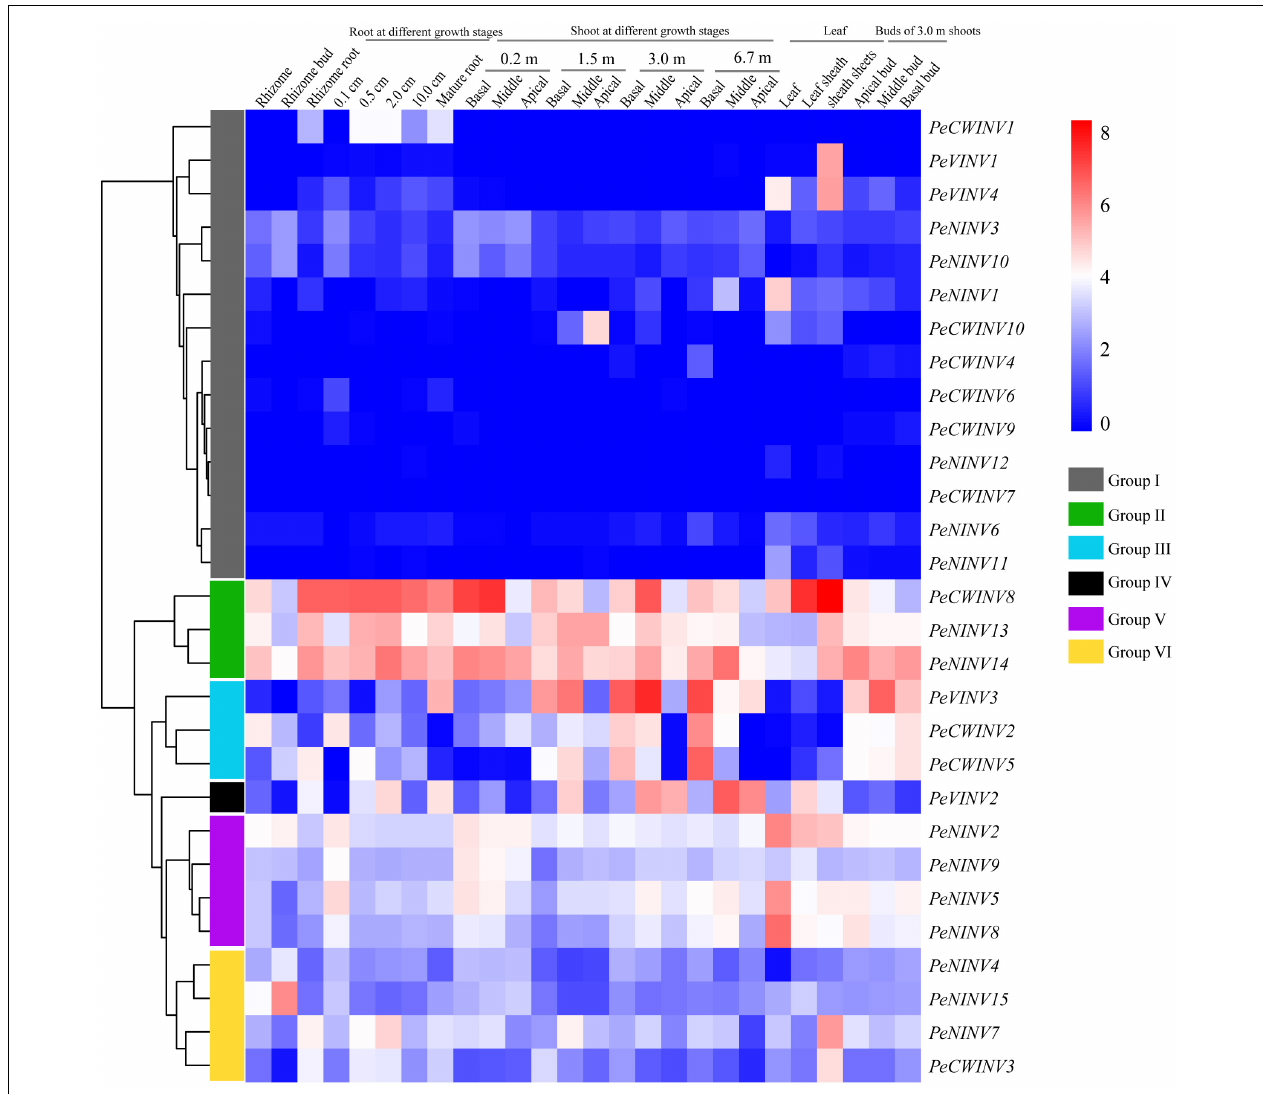
FIGURE 6 | Expression patterns of 29 PeINV s in 26 different tissues based on RNA-seq data of moso bamboo. FPKM-normalized values from RNA sequence data of different tissues in the moso bamboo were used to construct the heatmap. The PeINV s were divided into six groups.